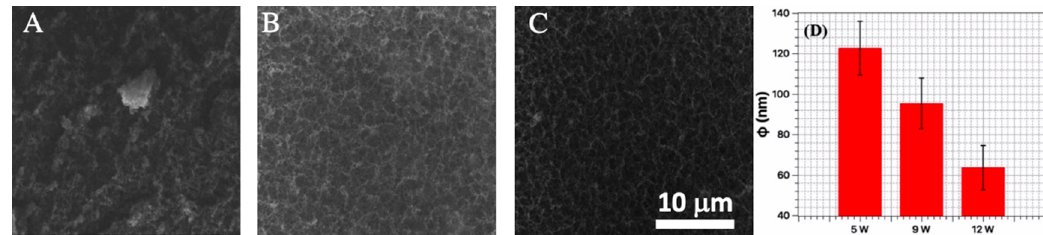
Figure 1. Scanning electron microscope (SEM) images of ( A ) nanofibrous titanium (NFTi) deposited layer on glass with laser power of 5 W; ( B ) NFTi deposited layer on glass with laser power of 9 W; and ( C ) NFTi deposited layer on glass with laser power of 12 W; ( D ) Column chart of fiber diameters by increased laser power.